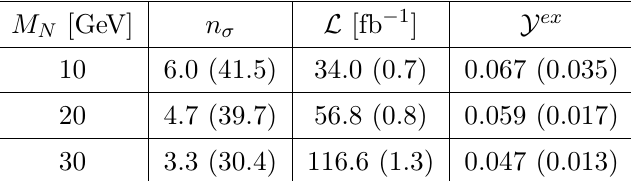
Table 3 . n σ is the significance of the proposed signature with only 50 fb − 1 luminosity. L is the required luminosity to achieve 5 σ significance. Numbers without (within) brackets corresponds to e − ( e + ) beam, respectively. Y ex represents 2 σ exclusion on Y 11